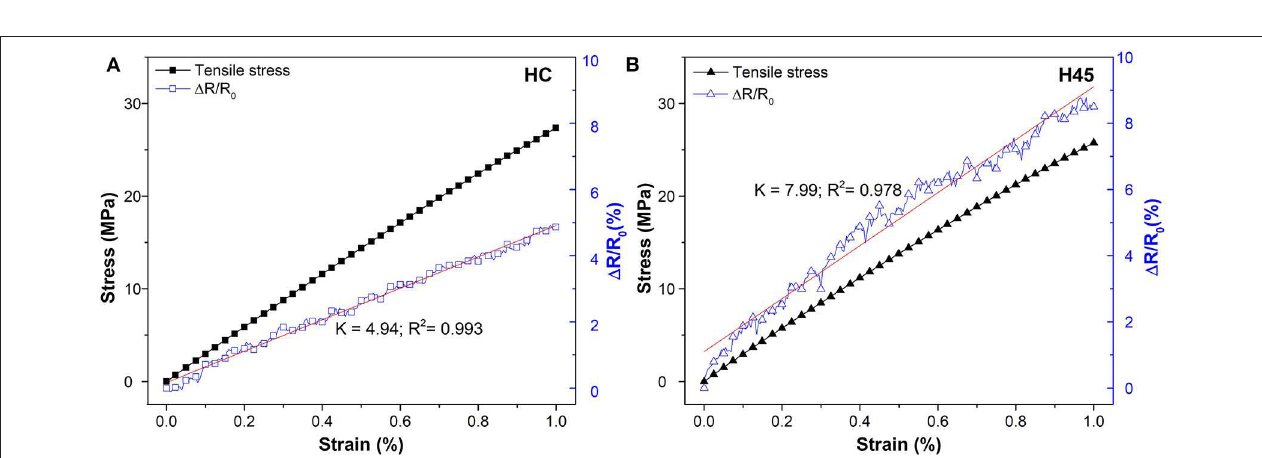
FIGURE 7 | Representative curves of mechanical and electrical ( 1 R/R 0 ) response of 3D-printed ABS/CNT nanocomposites HC (A) and H45 (B) during tensile test at 0.3%/min. Gauge Factor is determined by the slope of the best fitting line.